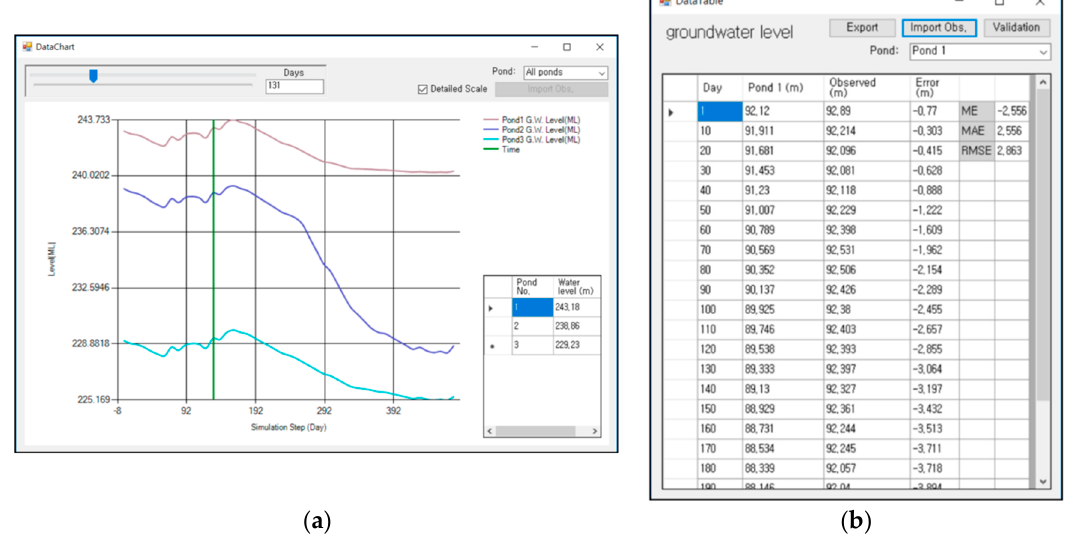
Figure 4. SIMPL program ( a ) chart tool and ( b ) table tool.